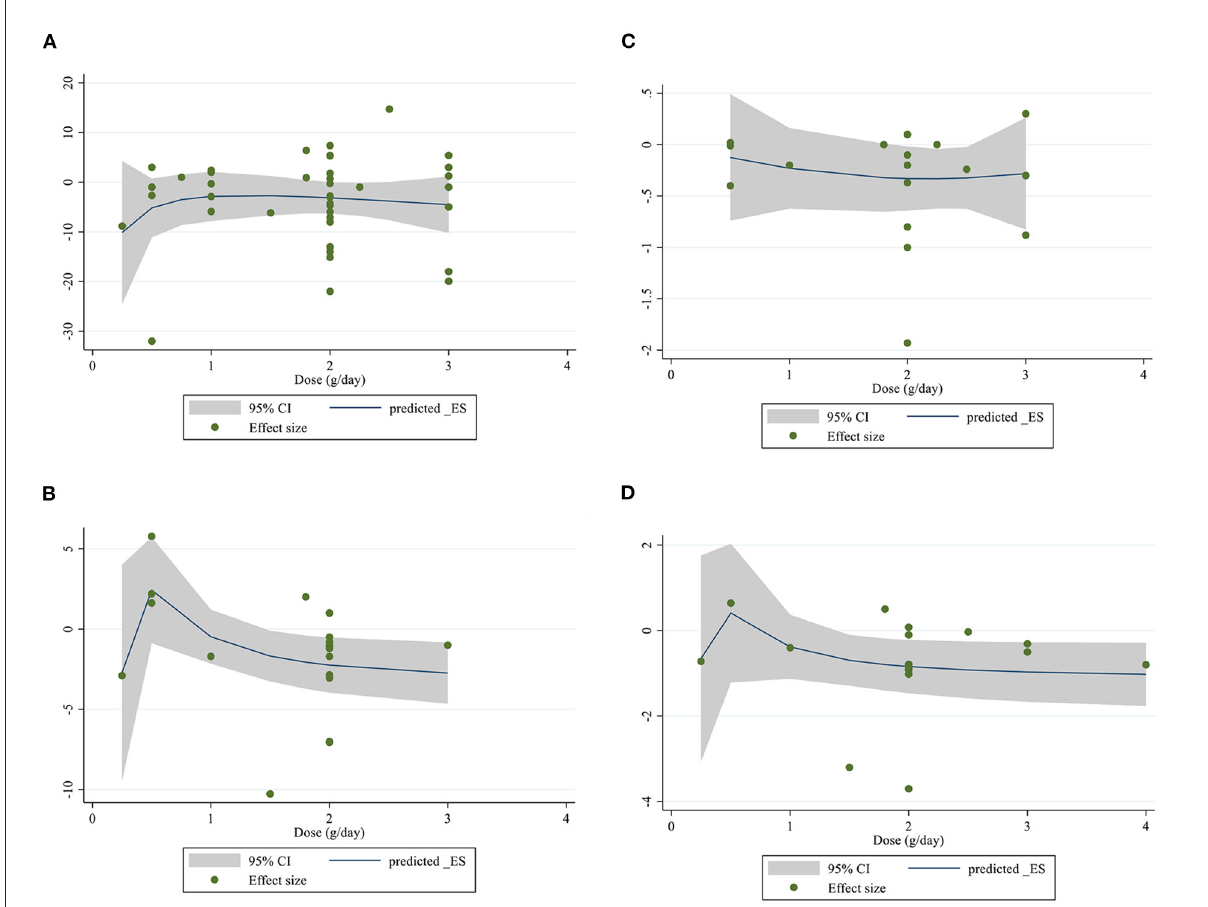
FIGURE4 Non-linear dose-response relations between L-carnitine consumption and absolute mean differences. Dose-response relations between dose (mg/day) and absolute mean differences in (A) FBG (mg/dl); (B) Insulin (pmol/l); (C) HbA1c (%); (D) HOMA-IR. FBG, fasting blood glucose; HOMA-IR, homeostasis model assessment for insulin resistance; HbA1C, hemoglobin